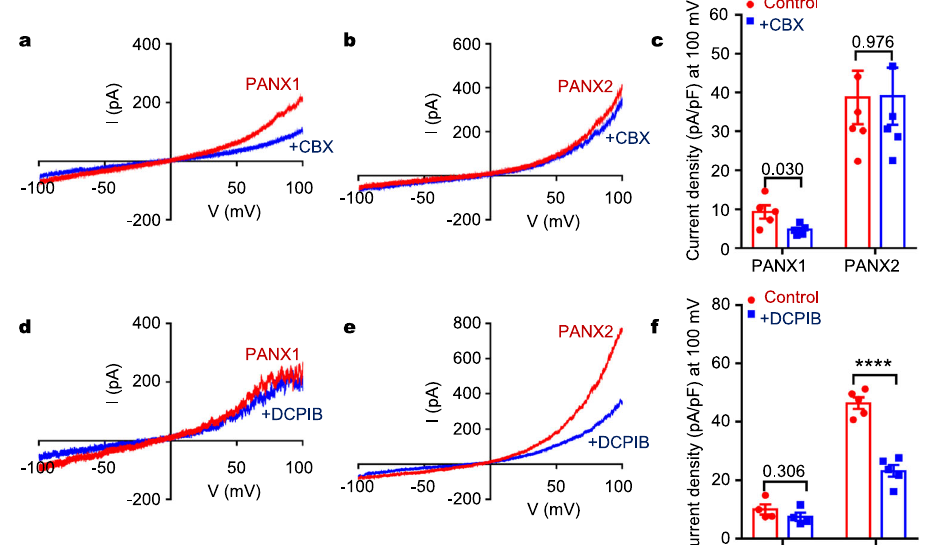
Fig. 5 | Pharmacology of human PANX2. a , b Current – voltage relationship of PANX1 ( a ) and PANX2 ( b ) in the absence or presence of 0.1mM CBX. c Current densities of PANX1- and PANX2-mediated whole-cell currents in the absence or presenceof0.1mMCBX(mean±SEM, n =5independentcells,unpaired two-tailed t -test). d , e Current – voltagerelationshipofPANX1( d )andPANX2( e )intheabsence